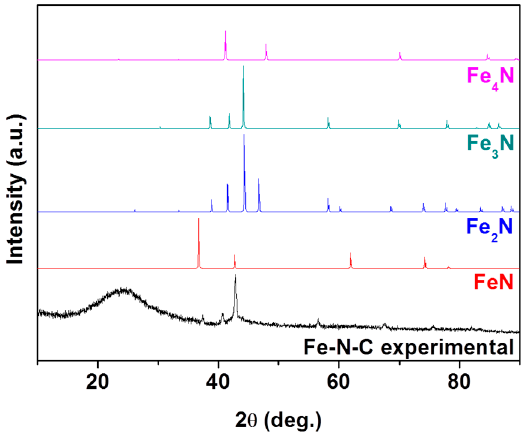
Figure 3. XRD patterns from the experiment compared with the theoretical generated pattern.